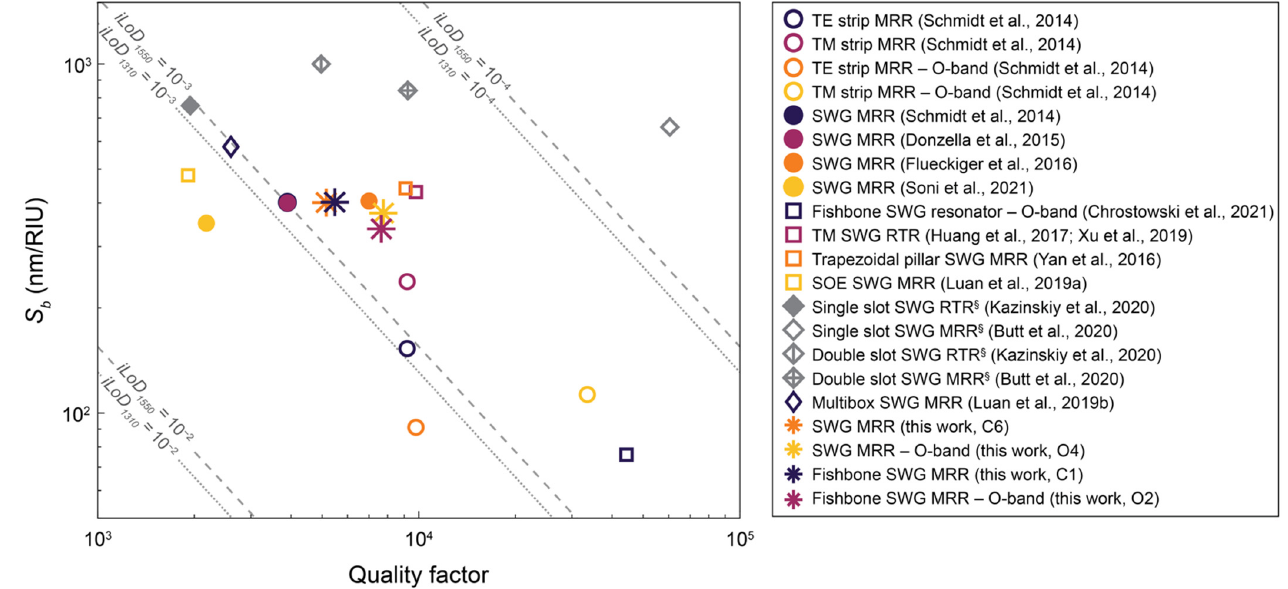
Figure 13. Reported silicon photonic resonator sensors performance comparison in terms of quality factor, S b , and iLoD . All sensors operate in the C-band unless marked otherwise. For works that reported sensor performance data for multiple sensor geometries, the best-performing design has been included in this plot. The sensors include quasi-transverse electric (TE) strip MRR [21], quasi- transverse magnetic (TM) strip MRR [21], TE strip MRR (O-band) [21], TM strip MRR (O-band) [21], SWG MRR [19,21,29,39], fishbone SWG resonator [1], TM SWG racetrack resonator (RTR) [51,52], trapezoidal pillar SWG MRR [53], substrate overetch (SOE) SWG MRR [6], single-slot SWG RTR [54], single-slot SWG MRR [55], double-slot SWG RTR [54], double-slot SWG MRR [55], multibox SWG MRR [3], and the best-performing C-band and O-band boneless (C6 and O4) and fishbone (C1 and O2) SWG MRRs reported in this work (C6 achieved S b,ave = 401 nm/RIU, Q = 5.2 × 10 3 , and iLoD = 7.5 × 10 − 4 RIU; O4 achieved S b,ave = 374 nm/RIU, Q = 7.8 × 10 3 , and iLoD = 4.5 × 10 − 4 RIU; C1 achieved S b,ave = 402 nm/RIU, Q = 5.5 × 10 3 , and iLoD = 7.1 × 10 − 4 RIU; O2 achieved S b,ave = 337 nm/RIU, Q = 7.6 × 10 3 , and iLoD = 5.1 × 10 − 4 RIU). Curves of constant iLoD are included on the plot for sensors with resonance wavelengths of 1310 and 1550 nm. Legend entries marked with a section sign (§) indicate sensors for which the reported Q and S b were obtained from simulations performed with gaseous cladding material (these markers are depicted in grayscale). Values reported for all other sensors are based on experimental measurements in water